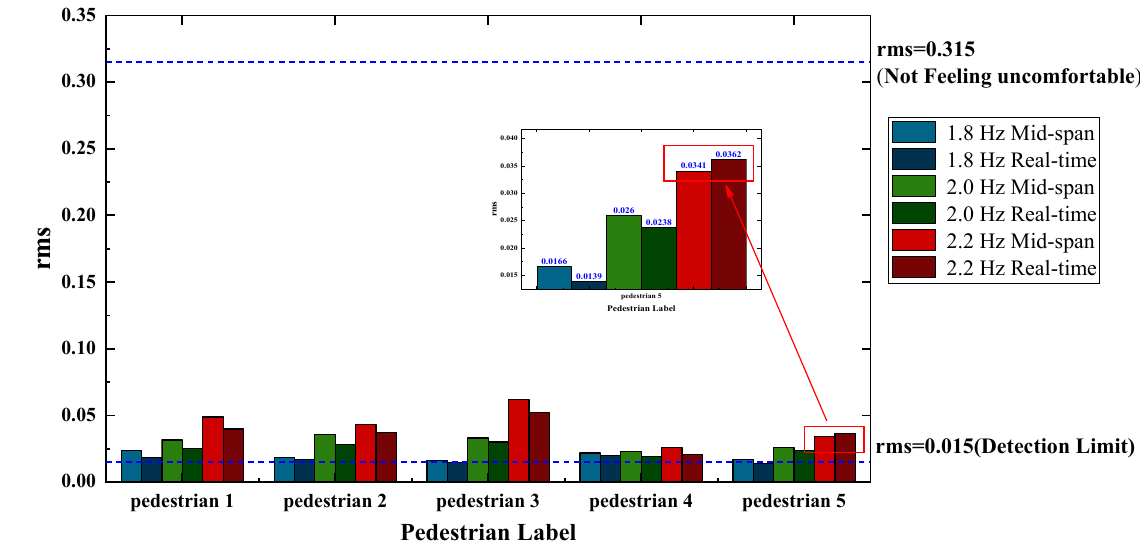
of pedestrian 1 at three frequencies; ( b ) global acceleration of pedestrian 2 at three frequencies; ( c ) global acceleration of pedestrian 3 at three frequencies; ( d ) global acceleration of pedestrian 4 at three frequencies; ( e ) global acceleration of pedestrian 5 at three frequencies.